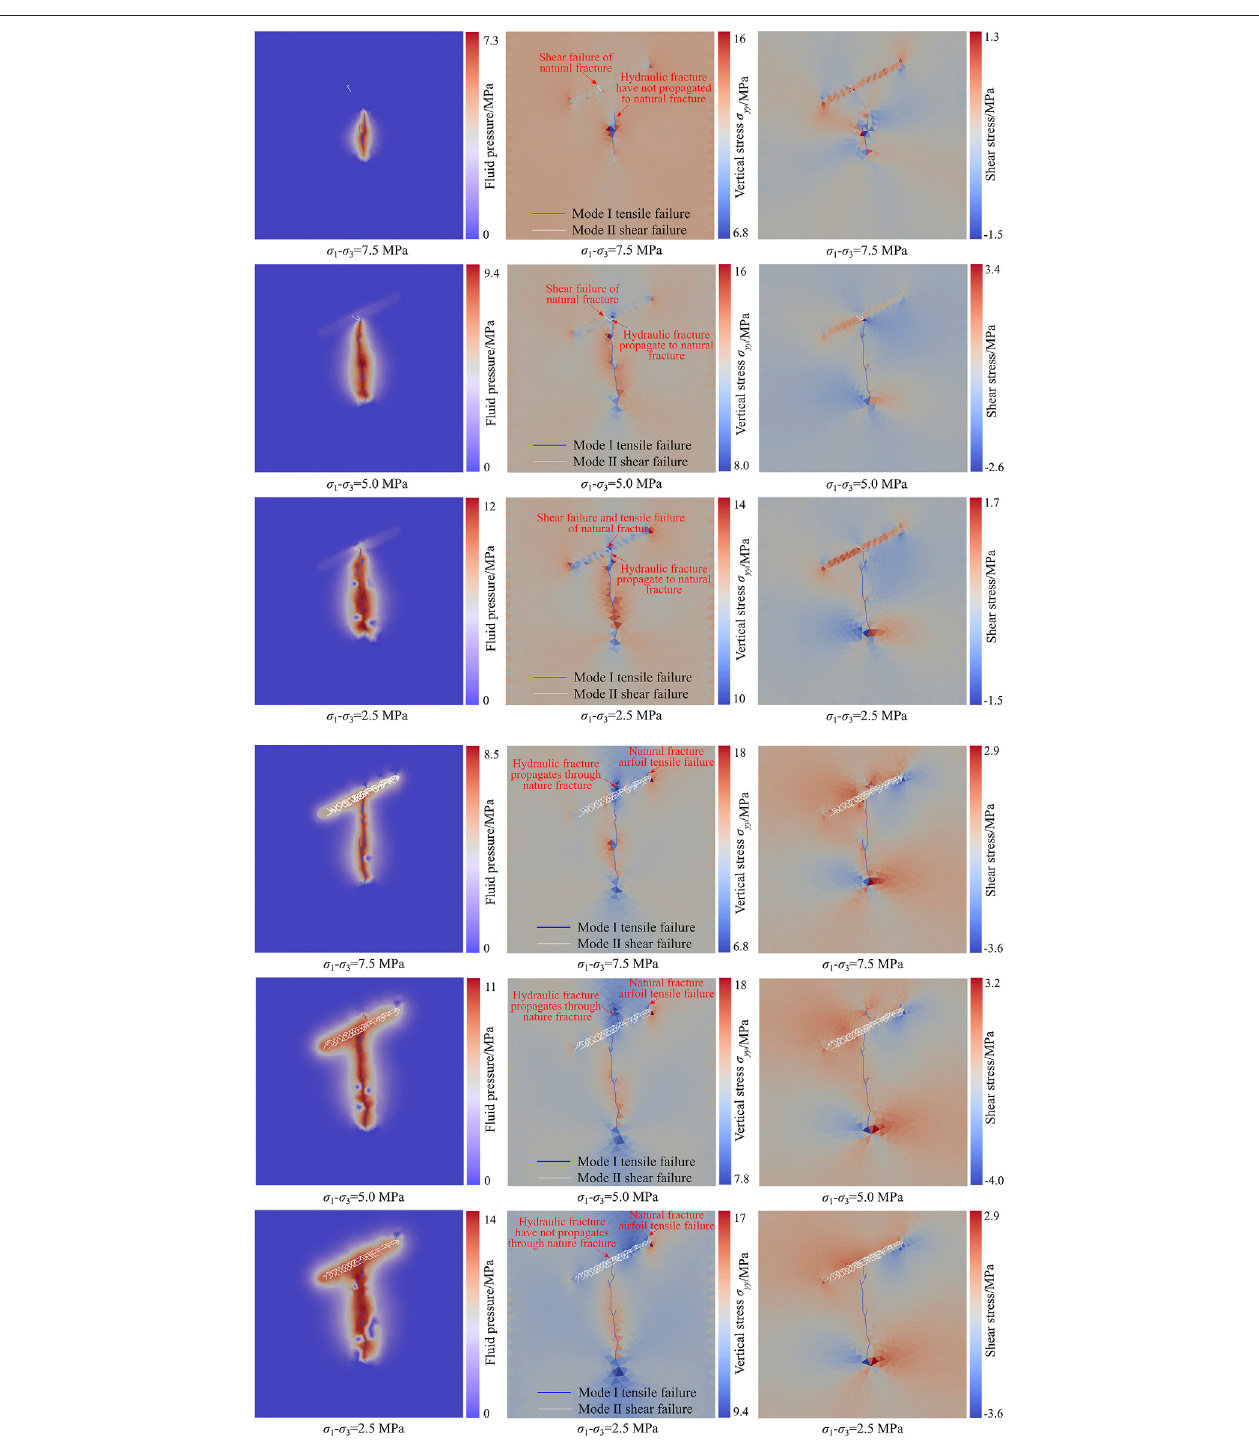
FIGURE9| Thedistributionof fl uid pressure,verticalstress, and shearing stressduring hydraulic fractures propagation under differentprincipalstressdifferences. (A) First failure of natural fractures; (B) airfoil propagation of natural fractures.